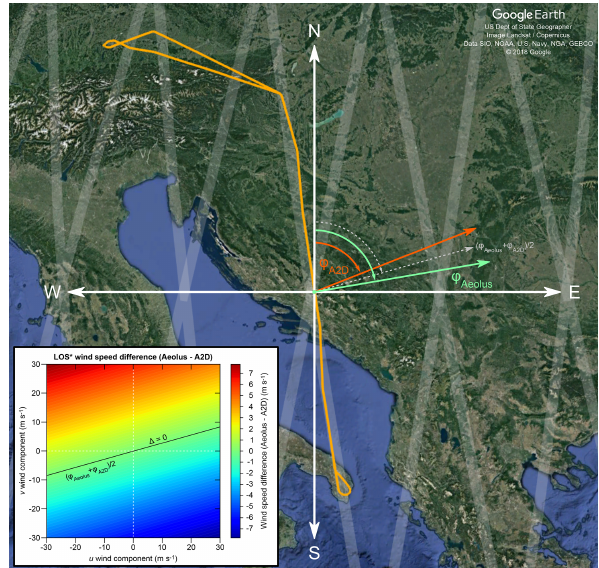
Figure 8. Diagram illustrating the different azimuth angles of Aeolus (green arrow) and the A2D (orange arrow), using the under- flight on 22 November 2018 (indicated by the orange flight track) as an example (background image: © 2018 Google). The inset de- picts the dependence of the LOS* wind speed difference on the zonal ( u ) and meridional ( v ) wind components for azimuth angles of ϕ A2D = 68 and ϕ Aeolus = 80 ◦ . When the azimuth angle of the wind vector meets the condition ϕ wind = (ϕ Aeolus /ϕ A2D )/ 2, i.e. the wind direction is 74 ◦ (dashed grey arrow), the LOS* wind speed differ- ence (cid:49) is